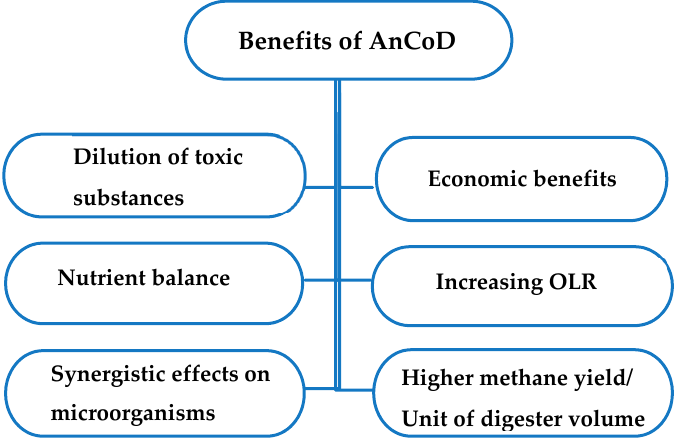
Figure 3. Advantages of anaerobic co-digestion Figure 3 . Advantages of anaerobic co-digestion systems . Figure 3 . Advantages of anaerobic co-digestion systems .